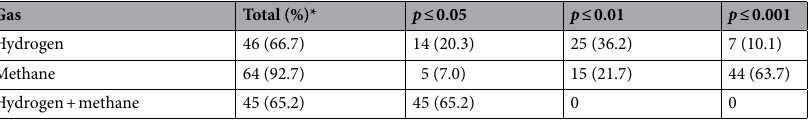
Table 4. Number of tests (%) with gas differences meeting various statistical significance cut-offs following mouthwash with chlorhexidine. *At least p ≤ 0.05.